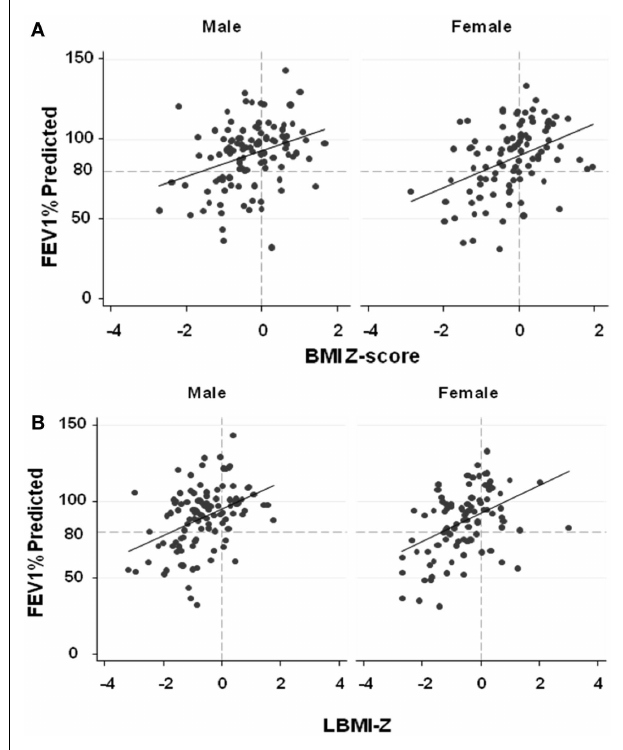
FIGURE 2 | (A) The associations between FEV1%-predicted and BMI- Z adjusted for age among males and females with CF. BMI- Z is positively associated with FEV1%-predicted in males ( p < 0.0001) and females ( p = 0.001) with CF. (B) The association between FEV1%-predicted and LBMI- Z adjusted for age among males and females with CF. LBMI- Z is positively associated with FEV1%-predicted in males ( p < 0.0001) and females ( p < 0.0001). (C) The association between FEV1%-predicted and FMI- Z adjusted for age among males and females with CF. No association between FEV1%-predicted and FMI- Z was found in males ( p = 0.26) while FMI- Z was positively associated with FEV1%-predicted in females ( p = 0.046) with CF.